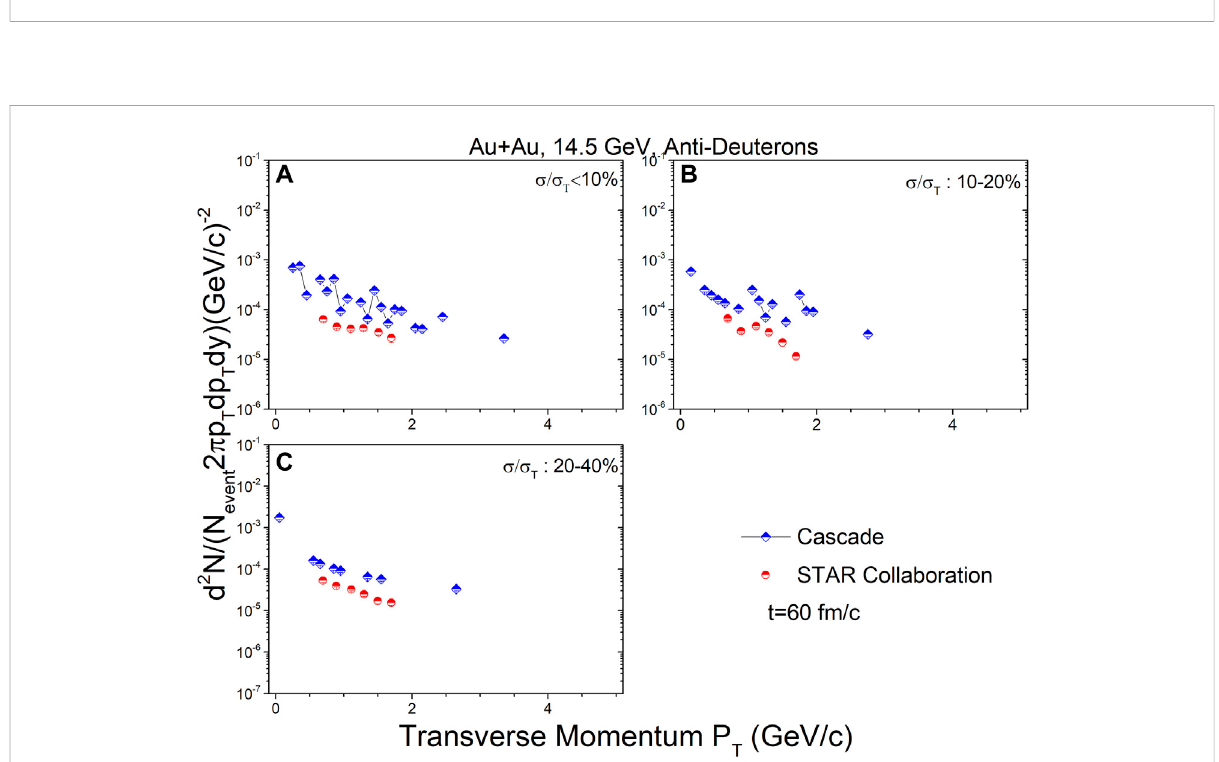
(cid:1)(cid:1)(cid:1)(cid:1) √ s NN In the = 14.5 GeV Au + Au collisions, 0, − ,10%, 10, − ,20%, 20, − ,40%, 40, − ,60% and 60, − ,80% centrality in t = 60 fm / c in the anti- deuteron transverse momentum spectrum. Calculations are represented by signs + lines. Experimental data from the STAR collaboration [27] are represented as circles. The parameter sets of ( R 0 , P 0 ) is (3.8 fm, 0.3 GeV/ c